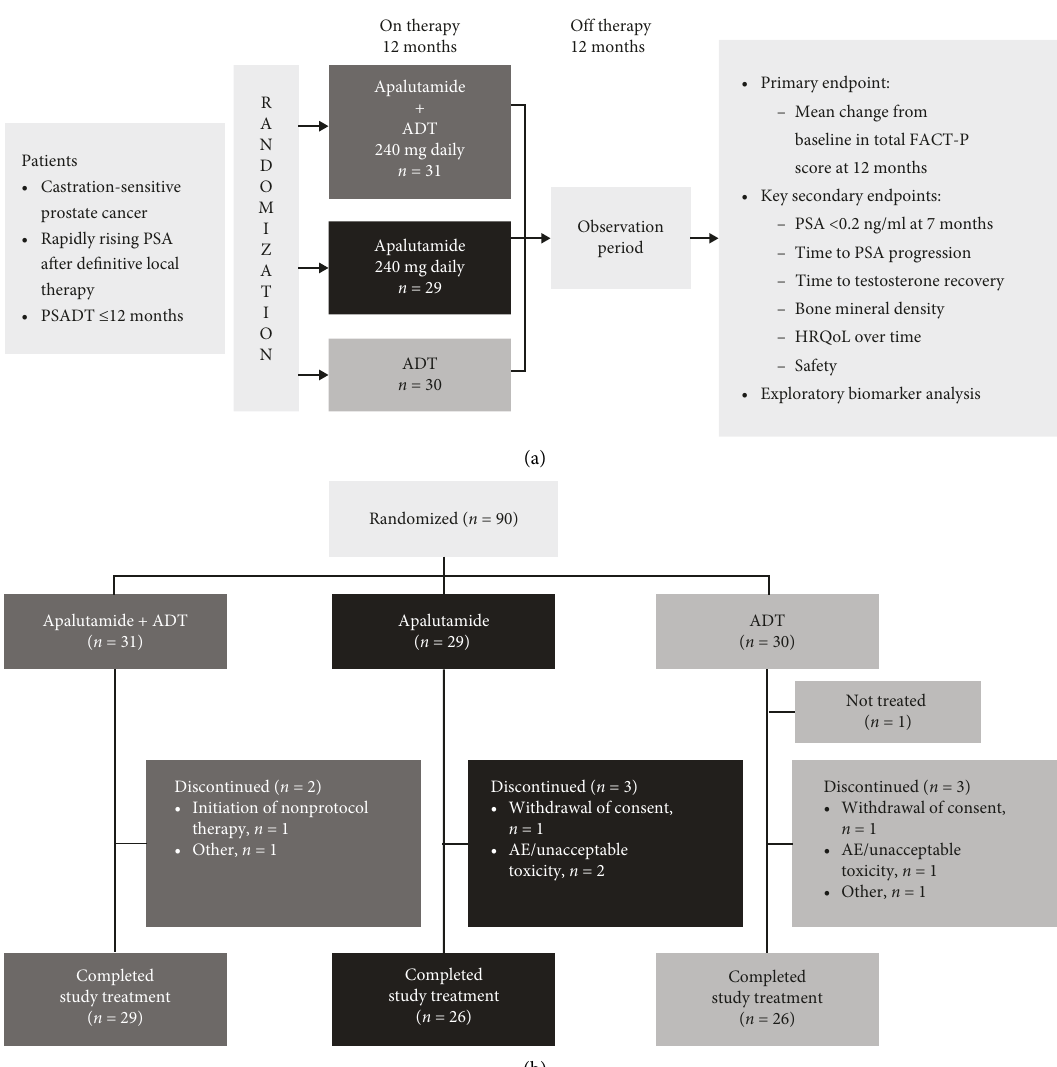
Figure 1: Study design (a) and CONSORTdiagram (b) for study ARN-509-002. Stratification factors for randomization: PSADT ( < 6 versus 6–12 months) and age ( ≤ 70 versus > 70